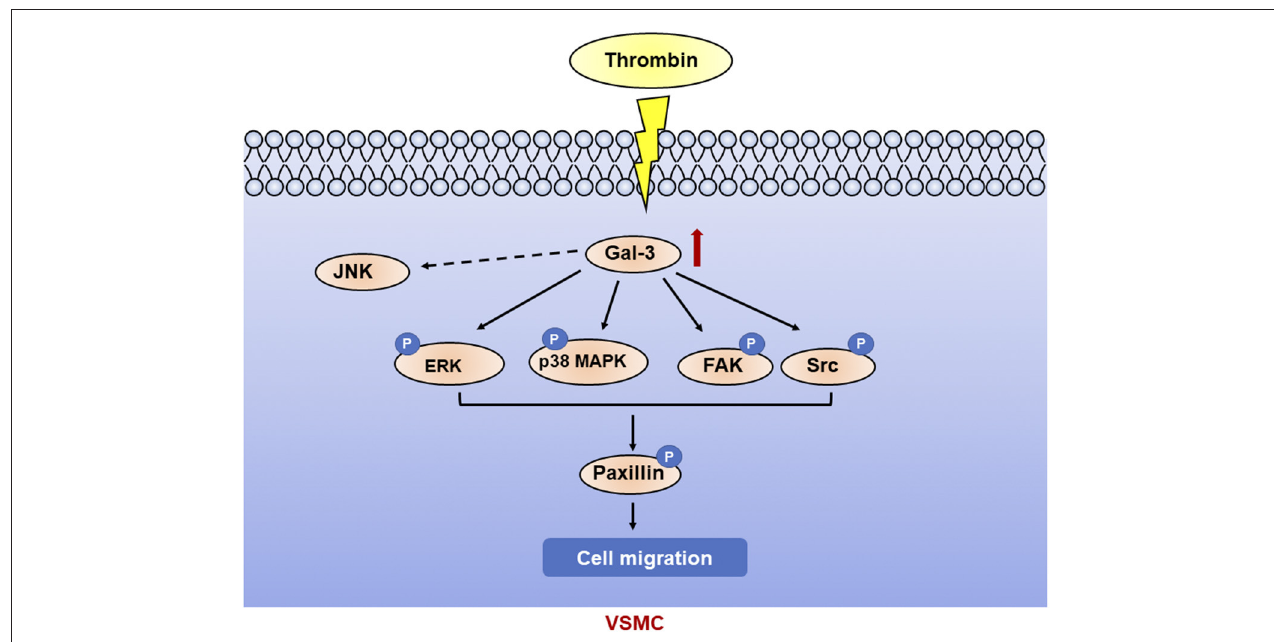
FIGURE 6 | Galectin-3 mediated thrombin-induced VSMC migration. Thrombin induced activation of p38, ERK, Src, and FAK signaling pathways via gal-3, leading to paxillin phosphorylation and cell migration in